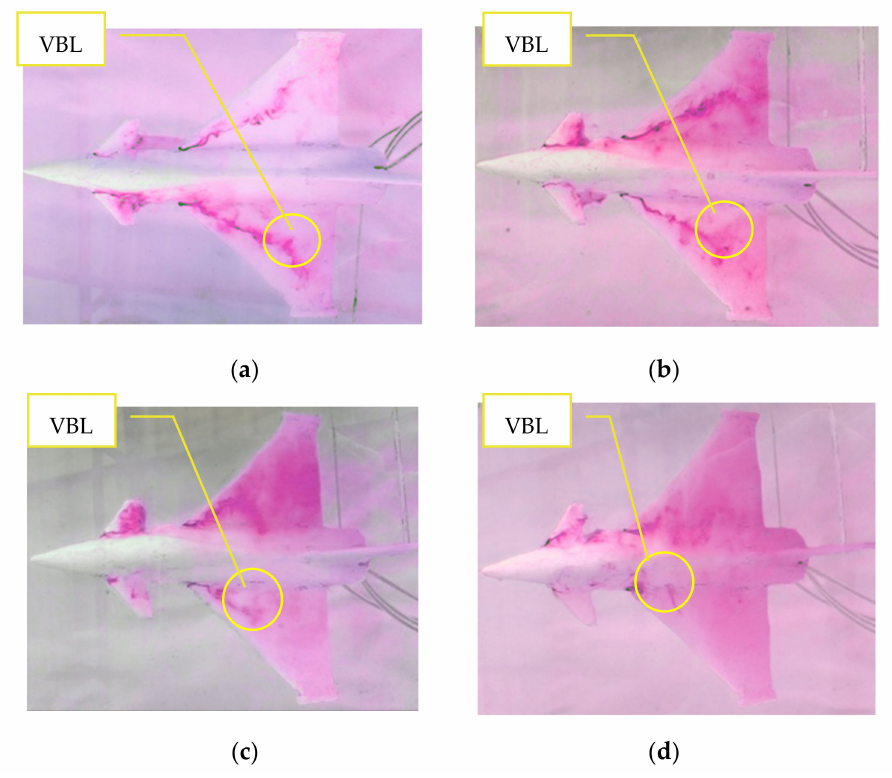
Figure 7. Water tunnel visualization and vortex breakdown location (VBL) on the EF-T; ( a ) AoA 20 ◦ ; ( b ) AoA 30 ◦ ; ( c ) AoA 40 ◦ ; ( d ) AoA 50 ◦